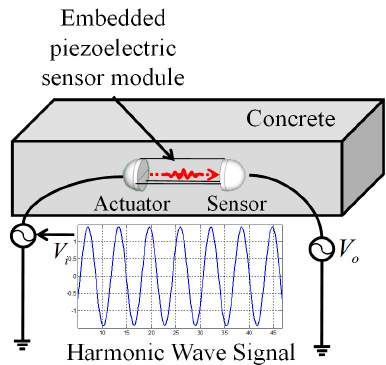
Figure 4. Schematic diagram of harmonic wave measurement.